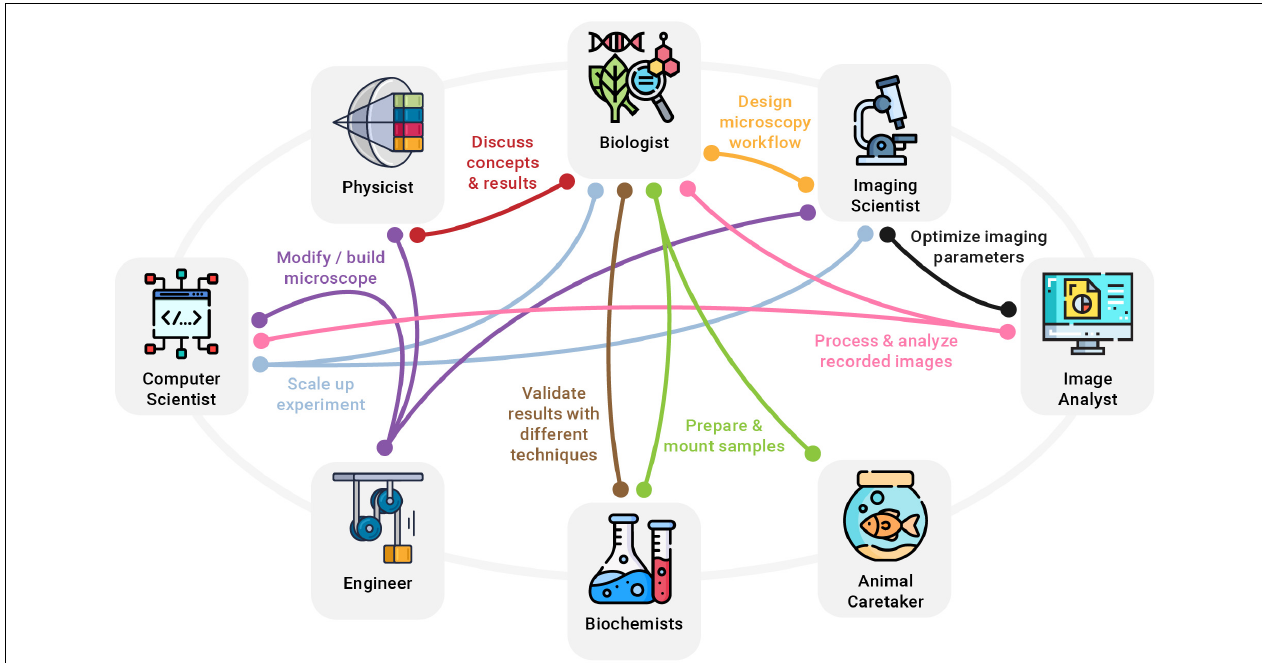
FIGURE 2 | A few examples of how a multitude of disciplines need to work hand in hand to turn new imaging ideas into reality. For example, an imaging scientist can provide valuable help to the biologist in designing a clear and reproducible microscopy workflow, while a biochemist might be needed to develop specialized fluorophores. At the same time, computer scientists, physicists, and engineers collaborate to modify or build an optical microscope needed for the